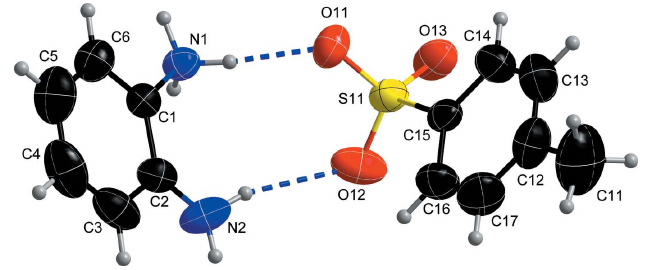
Figure 1 The molecular structure of 1 with displacement ellipsoids drawn at 50% probability level. Hydrogen bonds are shown as blue dashed lines.